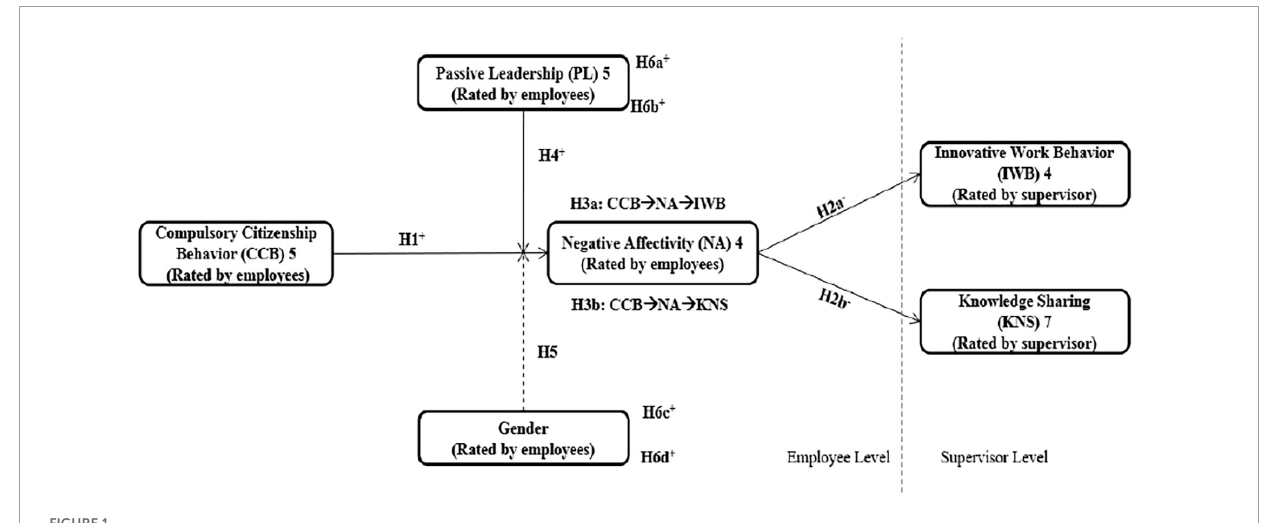
FIGURE1 Conceptual